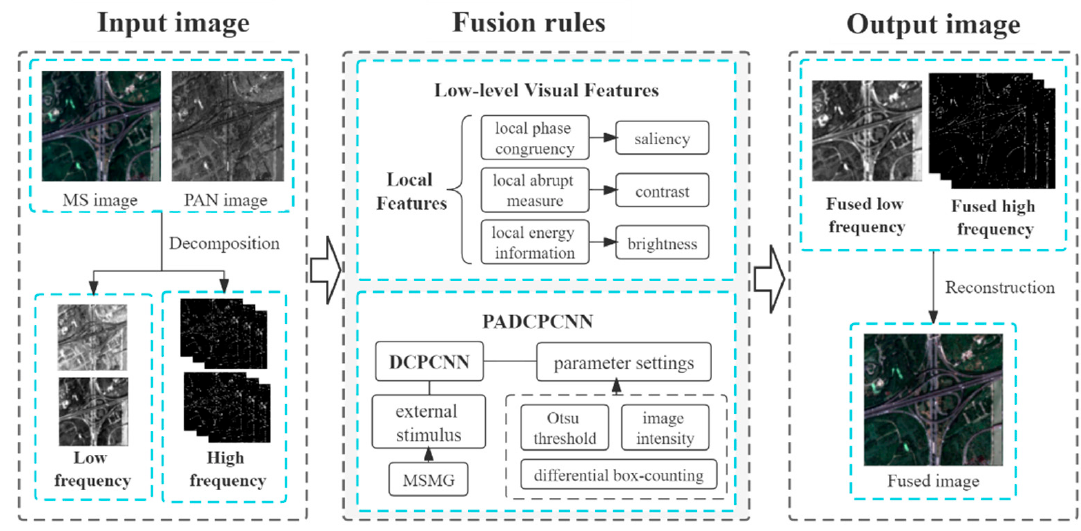
Figure 1. Framework of the proposed NSST-LLVF-PADCPCNN method.